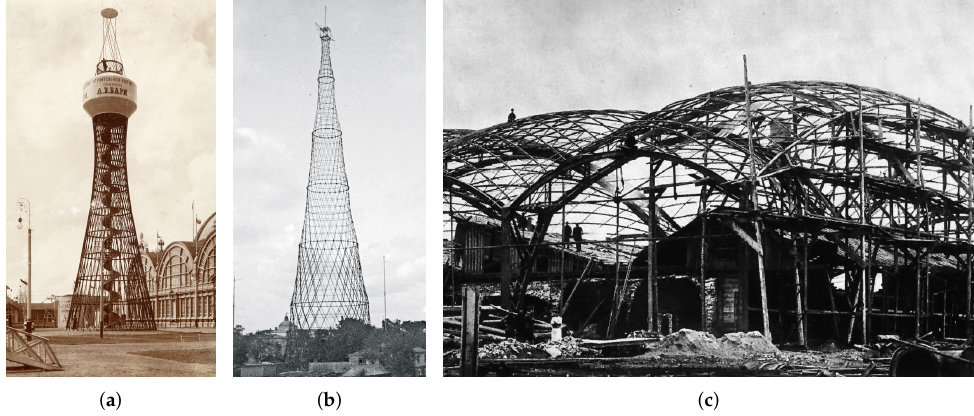
Figure 1. The world’s first diagrid hyperboloid water tower (37 m height) built by V. Shukhov for the All-Russian Exposition in 1896 in Nizhny Novgorod, Russia ( a ). The Shukhov radio tower, also known as the Shabolovka tower, build between 1919 and 1922 in Moscow, Russia ( b ). The world’s first double curvature steel diagrid by Shukhov (during construction), Vyksa near Nizhny Novgorod, 1897 ( c